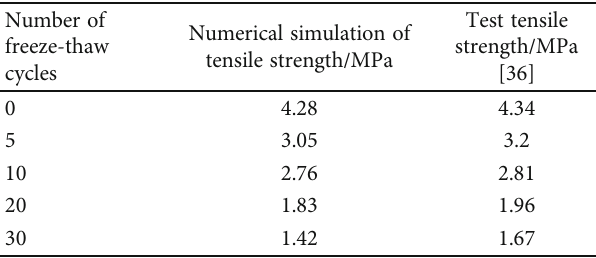
Table 4: Tensile strength of